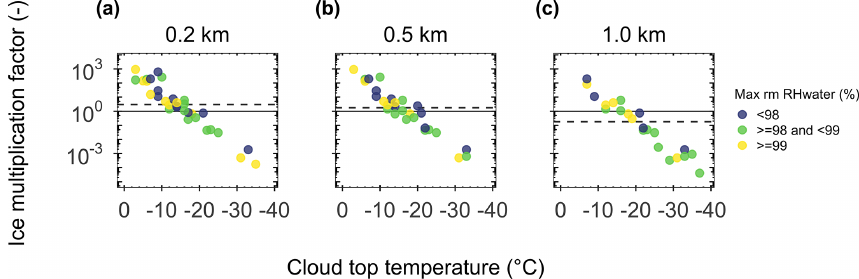
Figure 12. The ice multiplication factor versus cloud top temperature ( ◦ C) for each of the 52 snowfall events (coinciding with running mean RH ice ≥ 97% throughout the lower 2.7km) that were associated with cloud top temperatures warmer than − 38 ◦ C determining the highest possible seeder-feeder cloud using a distance threshold of (a) 0.2km, (b) 0.5km, and (c) 1.0km. The colours are indicative of the associated maximum running mean RH water ( < 98%, blue; ≥ 98% and < 99%, green; ≥ 99%, yellow). The median ice multiplication factor is shown by the dashed line. The solid line is drawn at an ice multiplication factor of